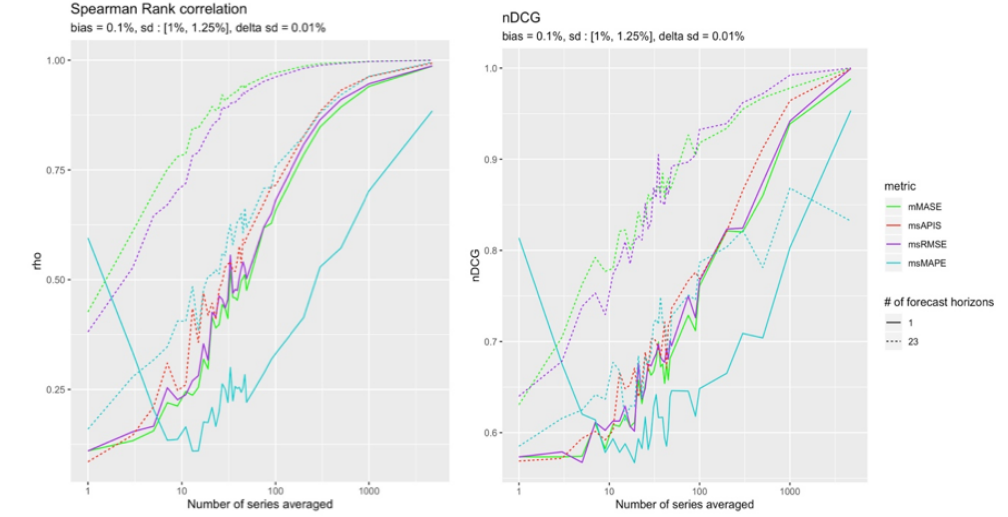
Figure 14. Spearman Rank correlation and nDCG for ( + − − )